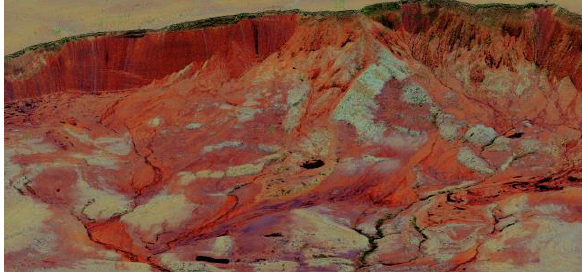
Figure 6. Reflectance composite image of the thaw slump and surrounding polygon terrain.